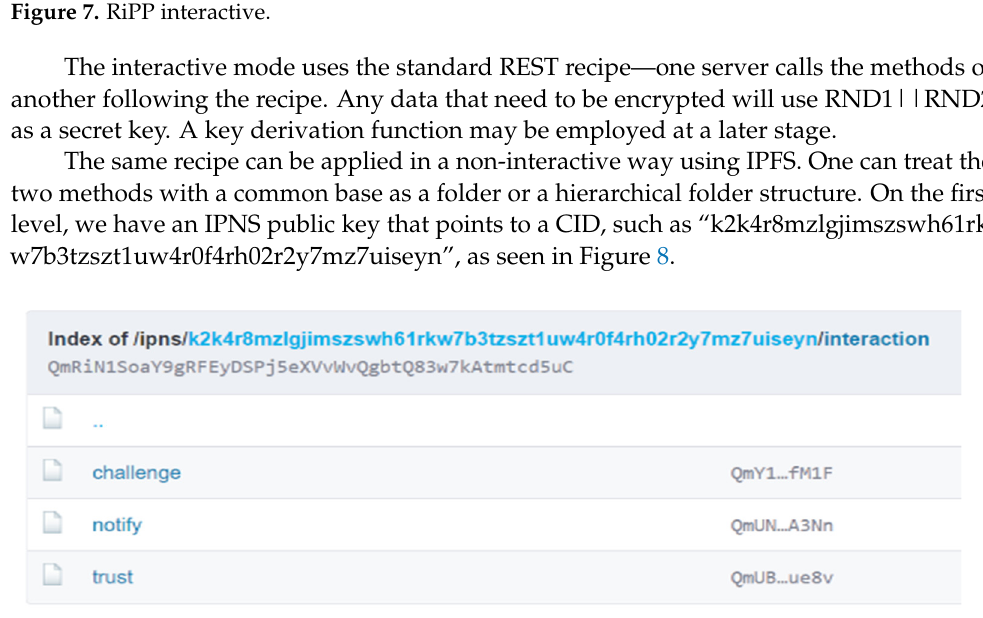
Figure 8. IPNS example.